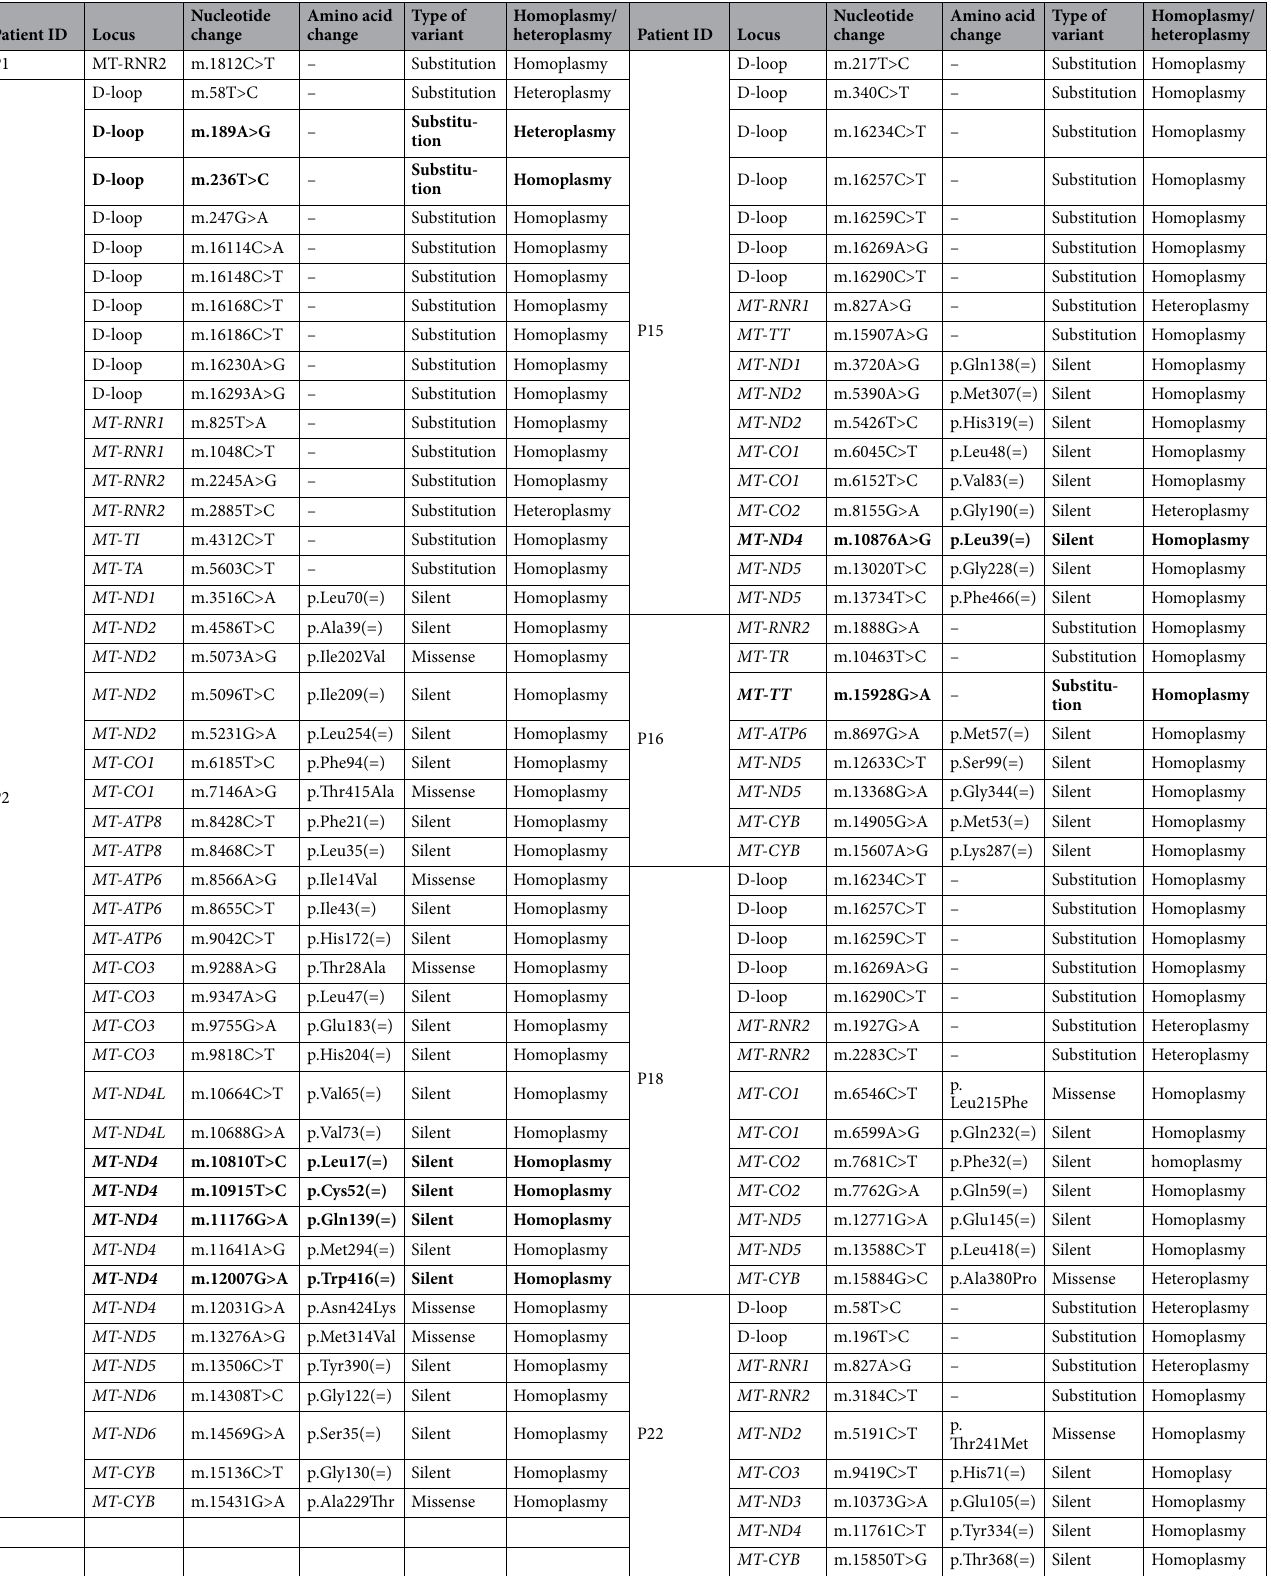
Table 4. Other variants in RRMS patients carrying one of the LHON mtDNA mutations. LHON Leber’s hereditary optic neuropathy, RRMS relapse-remitting multiple sclerosis. Mutations in bold were previously reported in LHON patients according to MITOMAP, HmtDB, ClinVar and MEDLINE-listed publications on life